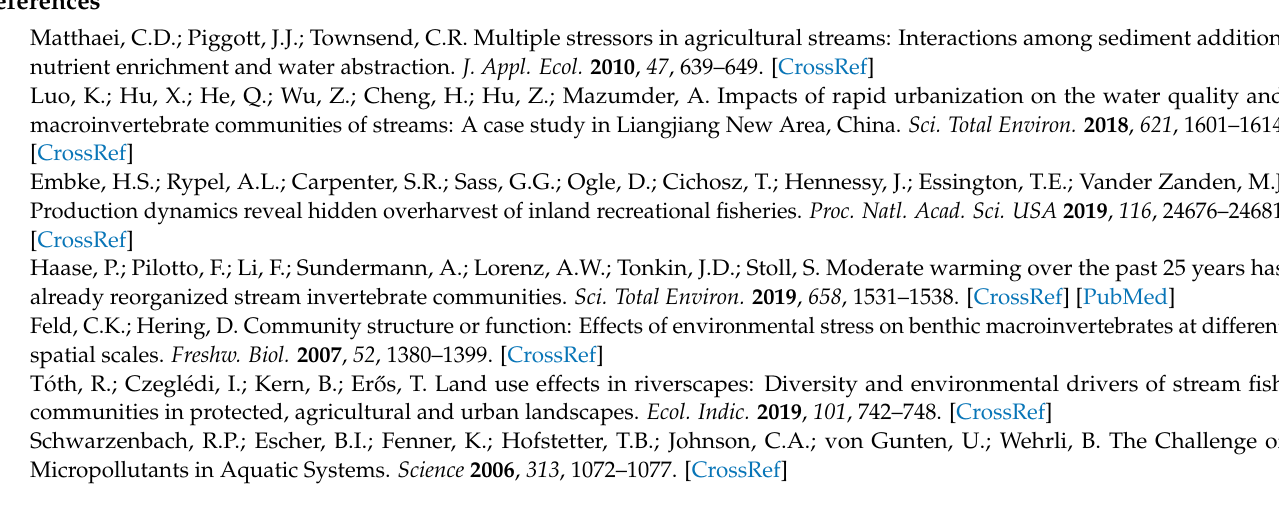
syndromes for fish